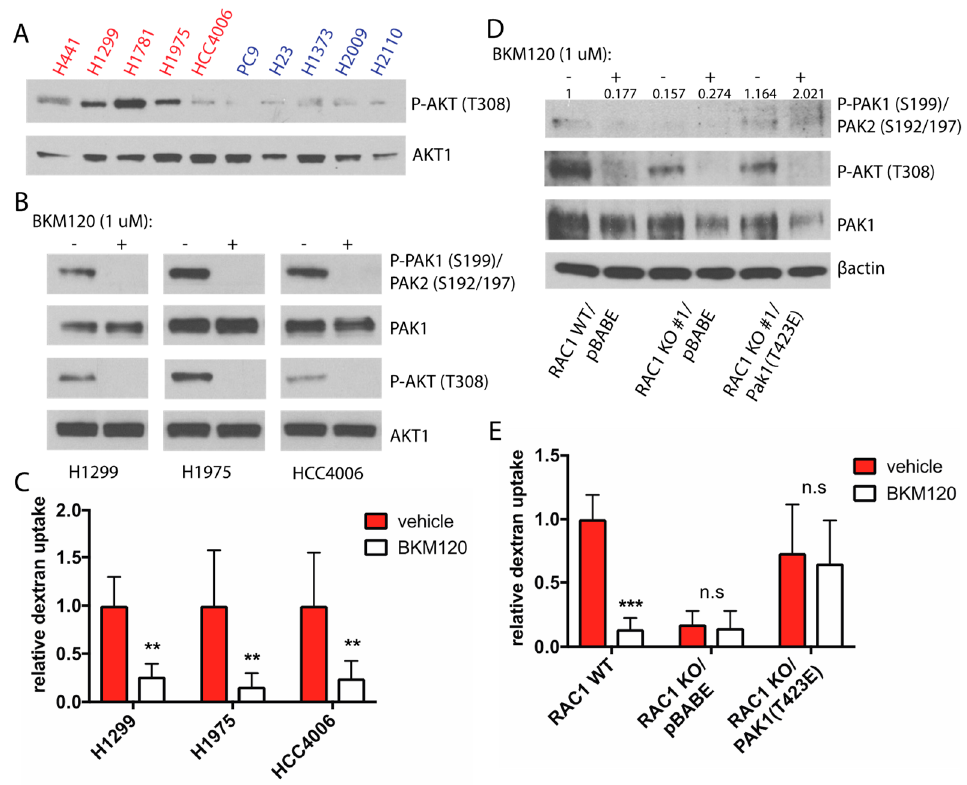
Figure 5. PI3K regulates Rac-driven macropinocytosis. ( A ) Immunoblot analysis of phospho-Akt (Thr308) in glucose independent (red) and glucose addicted (blue) cells following 6 h of glucose starvation. ( B ) Immunoblot analysis of Pak and Akt phosphorylation following treatment with vehicle or 1 µ m BKM120 for 1 h. ( C ) Quantification of FITC-dextran uptake in glucose starved cells treated with either vehicle or 1 µ m BKM120 for 1 h prior to incubation with FITC-dextran. Data is normalized to vehicle treated cells. Error bars indicate ± SD of 10 fields scored containing at least 10 cells, and statistics was calculated using Student’s t -test. ( D ) Immunoblot analysis of Pak signaling in Rac1 KO H1299 control cells or cells stably overexpressing the constitutive active Pak1 mutant T423E following treatment with vehicle or 1 µ m BKM120 for 1 h. Densitometry was used to quantify P-Pak band intensities normalized to T-Pak1. ( E ) Quantification of FITC-dextran uptake in glucose starved Rac1 WT, Rac1 KO, and Rac1 KO/Pak1 (T423E) cells treated with vehicle or 1 µ m BKM120 1 h prior to incubation with FITC-dextran. Data is normalized to Rac1 WT cells, error bars indicate ± SD of 10 fields scored containing at least 10 cells. Significance was calculated using ANOVA with Holm-Sidak multiple comparisons between control and BKM120 treated cell lines, ** p < 0.005, *** p < 0.0001.